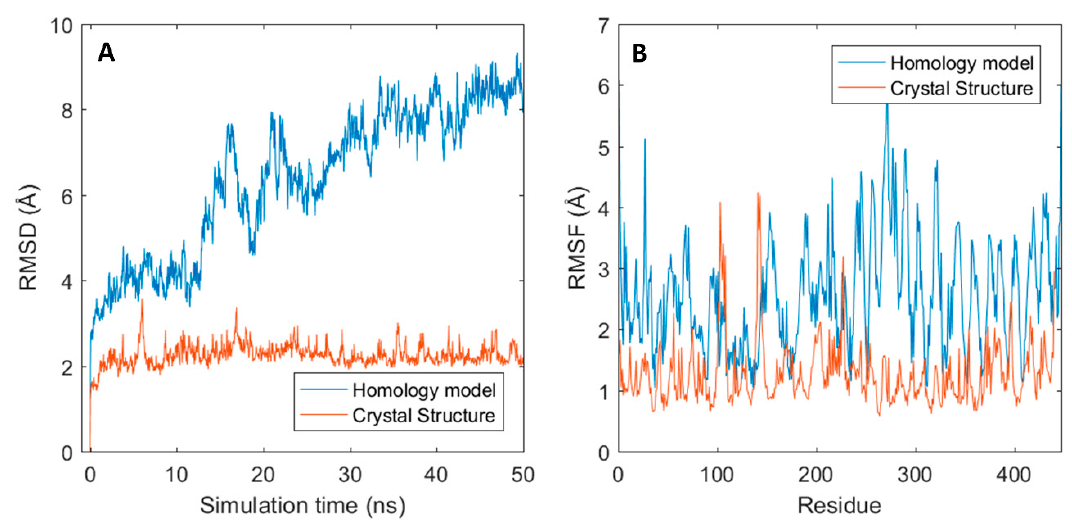
Figure 5. Gantenerumab structural fluctuation for both homology and crystal structure. ( A ) RMSD graphs for both structures through time. ( B ) Root-mean-square fluctuation (RMSF) for all residues.